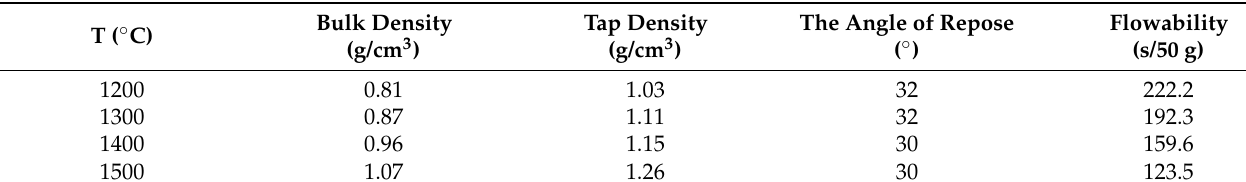
Table 3. Density and flowability powders prepared with different sintering temperatures.